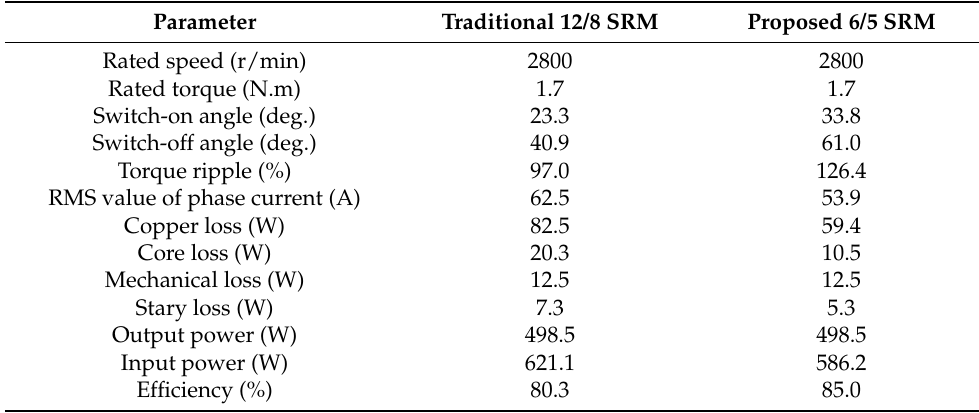
Table 2. Steady-state characteristics comparison of the two motors under rated operating condition in